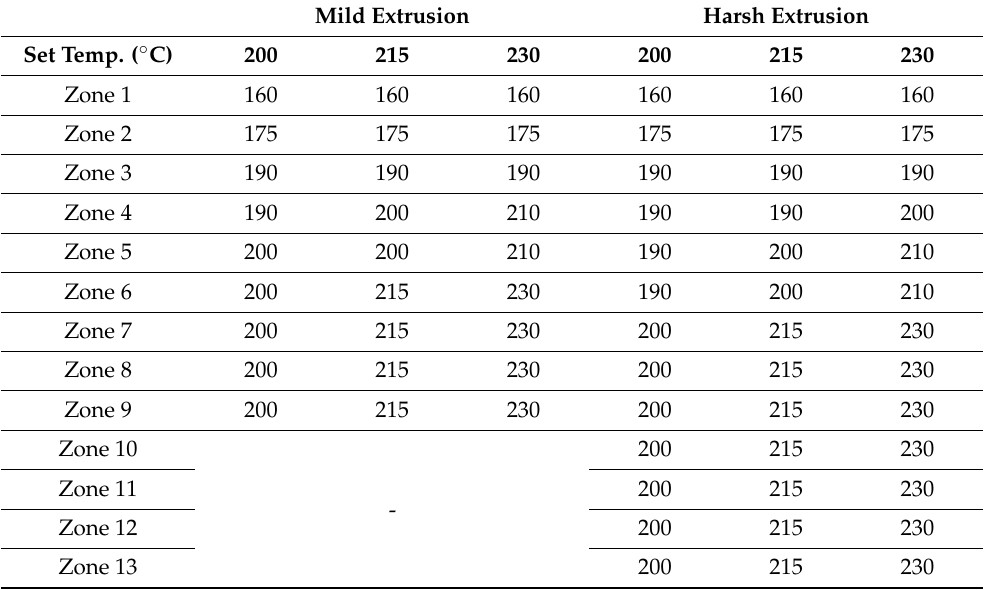
Table 1. Temperature conditions inside two twin-screw (mild and harsh) extruders depicted in Figure 1. Extrusion rate is 50 kg/h and screw speed is 200 or 250